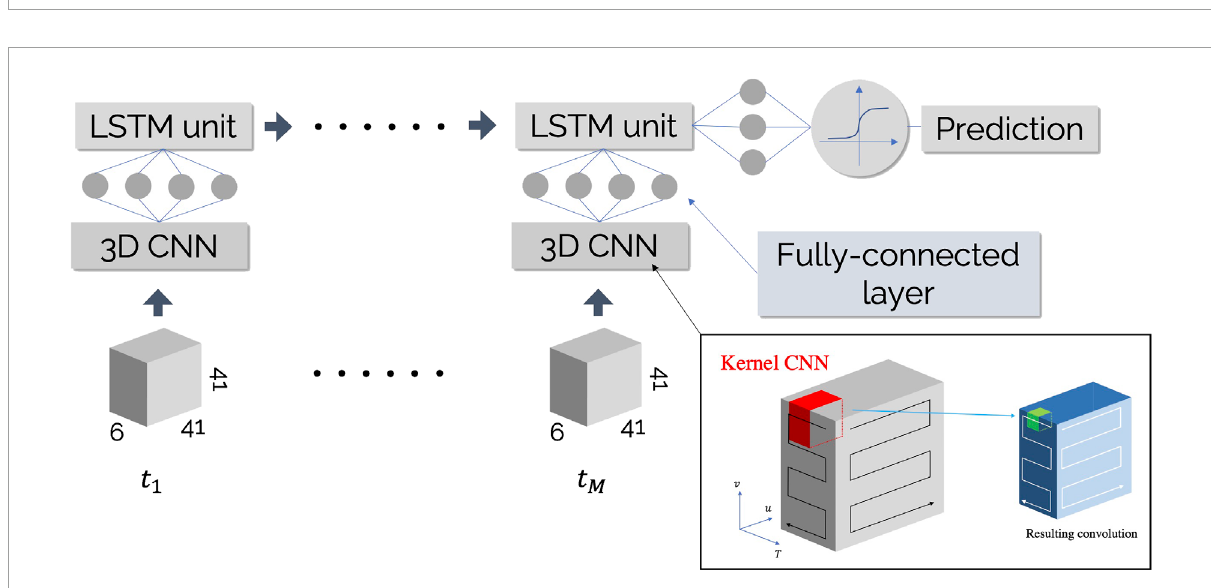
FIGURE 11 Schematic of a CNN that applies 3-D ( u , v ; T ) filter layers to an ̂ DEM ( u , v ; T ; t ) hypercube of AIA-based data.